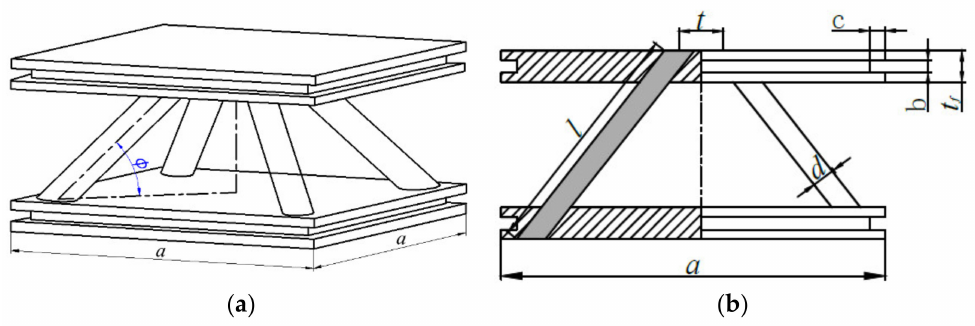
Figure 1. Diagram of wood-based pyramid sandwich structure. ( a ) Axonometric drawing; ( b ) section